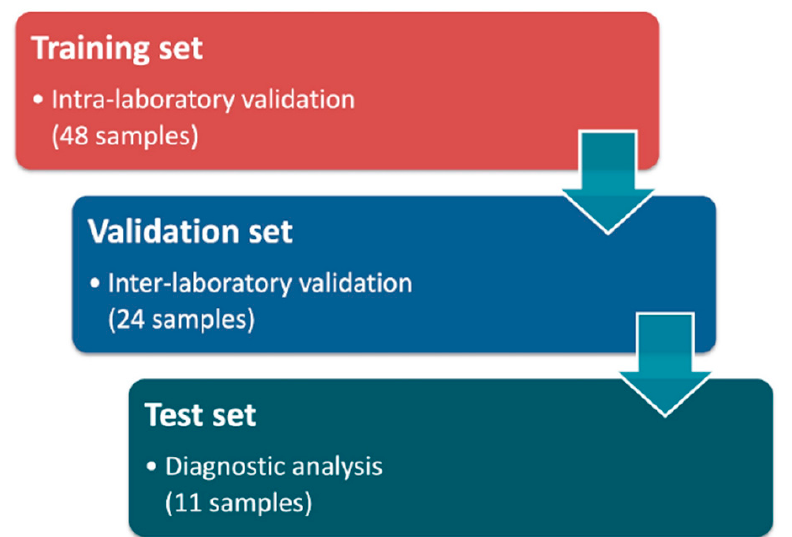
Figure 3. One4Two  validation performance flow chart. The laboratory method performance